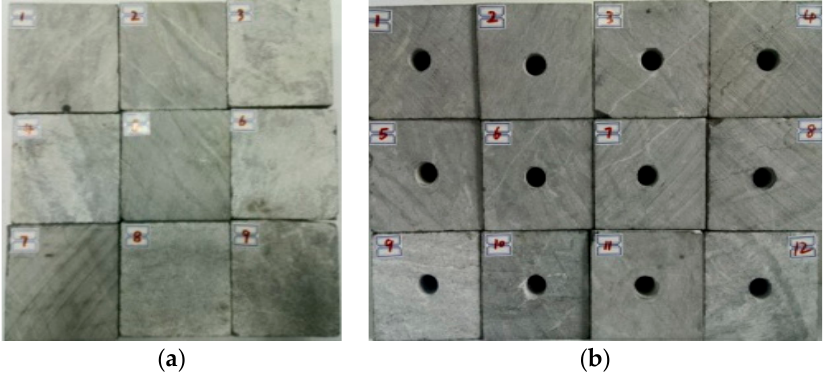
Figure 1. Experimental samples. ( a ) intact rock samples; ( b ) holey rock samples.